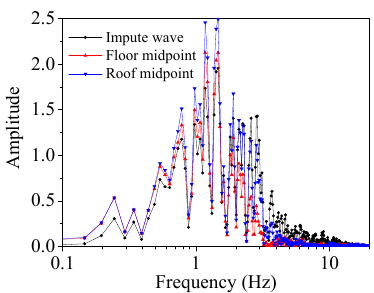
Figure 14. Fourier spectrum comparison between monitoring points and incident seismic wave.